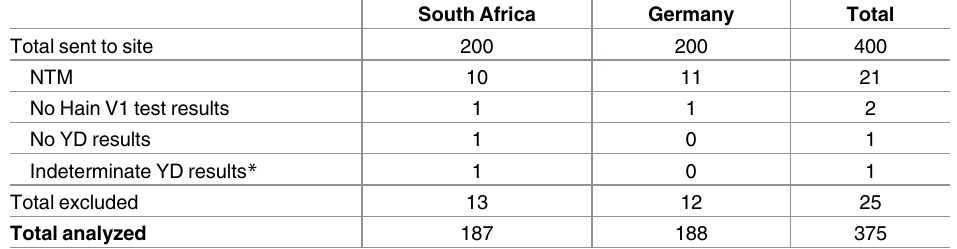
Table 2. Phase 1 sample characteristics and total number of samples included in the line probe assay comparative performanceassessment by